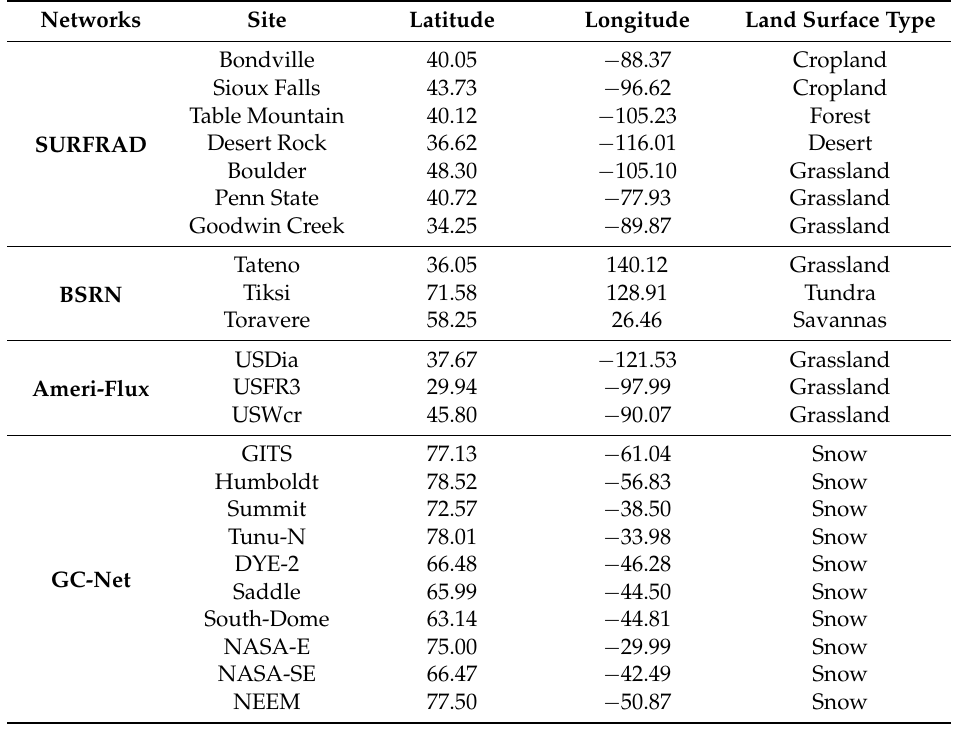
Table 1. List of ground sites: networks, site names, geolocations, and surface types.